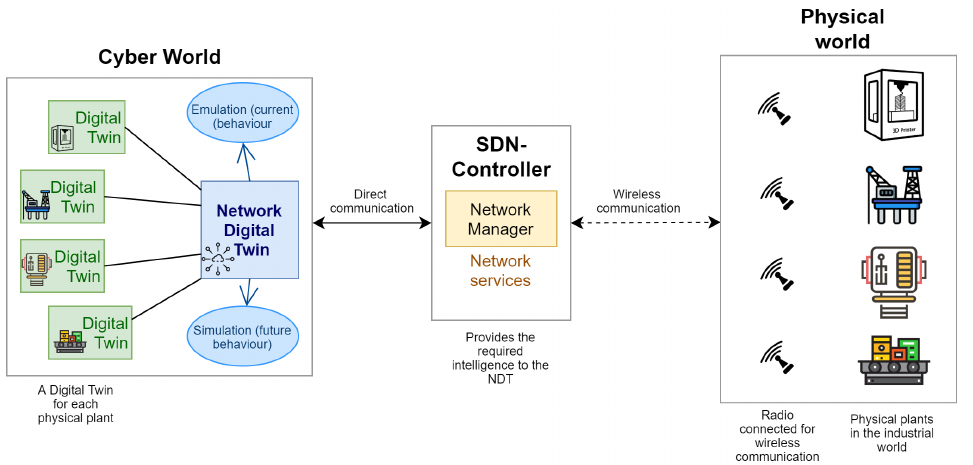
Figure 3. Digital Twin Networking based architecture for industry